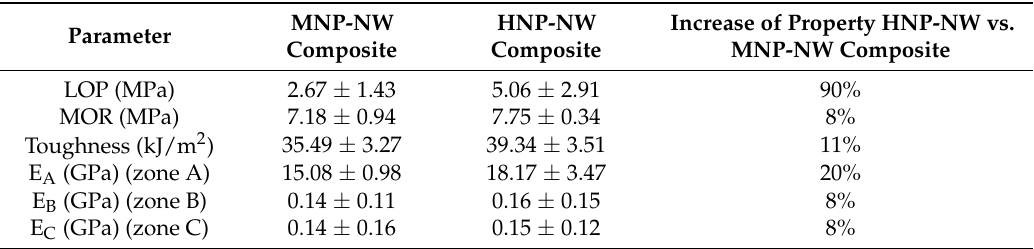
Table 4. Average values and standard deviation of LOP, MOR, E modulus, and toughness, obtained from tensile tests and increase of these values for the composites prepared with the HNP-NW fabric with respect to the ones prepared with the MNP-NW